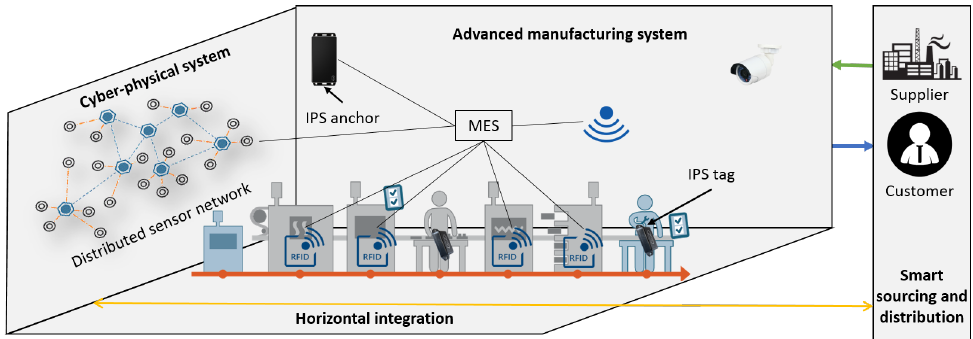
Figure 3. Intelligent Space (iSpace)-based integrated sensor signals can be used to monitor the work of the operators, extract their tacit knowledge, synchronize activities and provide contextualized information.